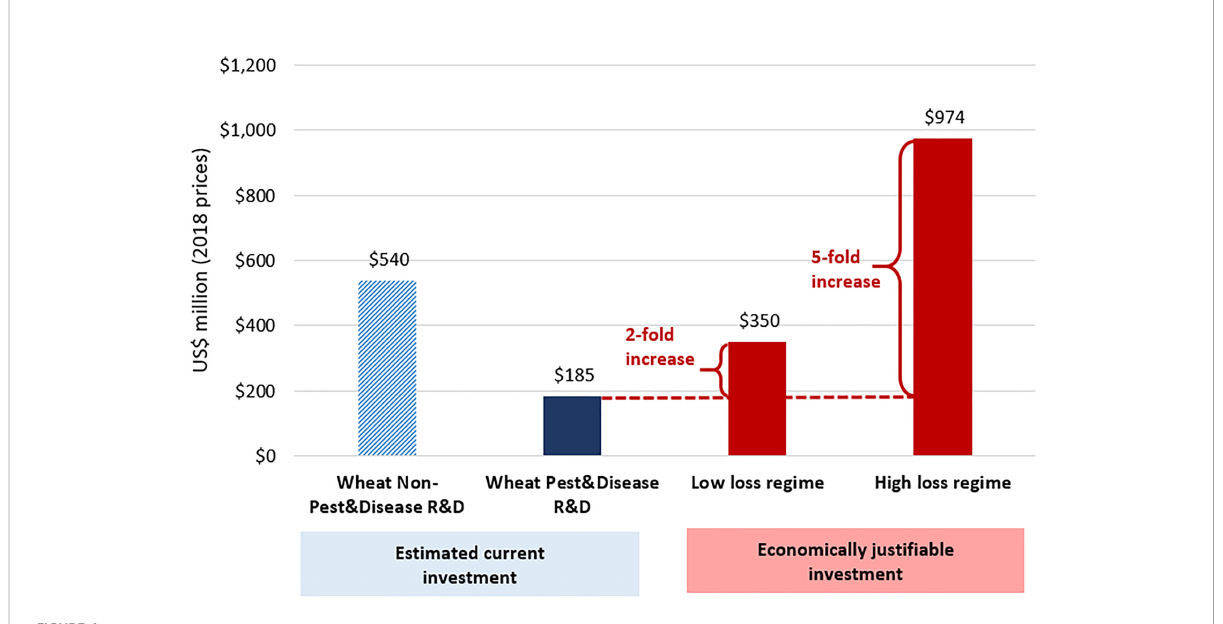
FIGURE 4 The Investment Bottom Line. All dollar estimates represent average annual values expressed in 2018